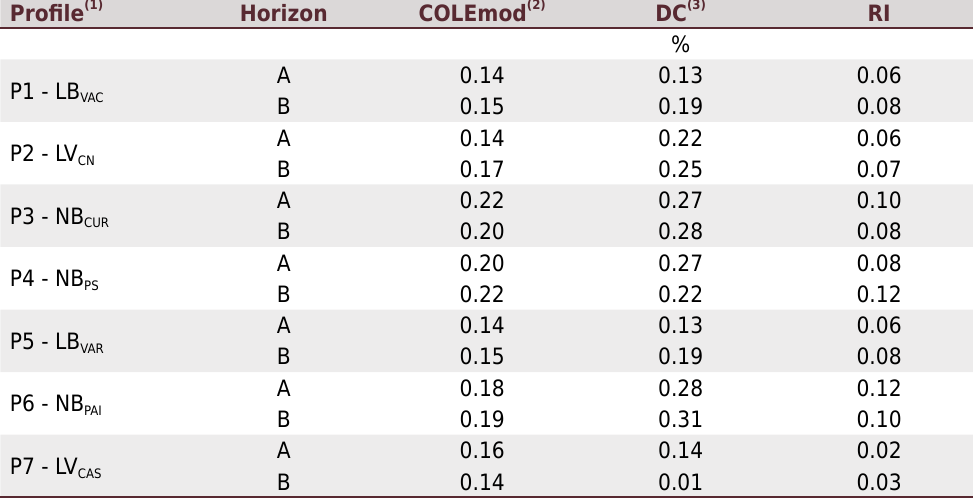
Table 5. Summary of results for the shrinkage indexes of the soils by the Syringe Method - COLEmod (Coefficient of linear extensibility), Metallic Mercury Method - DC (Degree of contraction of soil), and the Ring Filling Sand Method - RI (Shrinkage